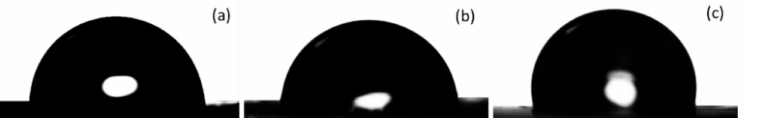
Figure 6. Images of the water droplets used for contact angle measurements of the electrospun scaffolds: ( a ) P(3HB), ( b ) P(3HB-co-3HV) and ( c ) P(3HB-co-3HV): mcl-PHA blend.